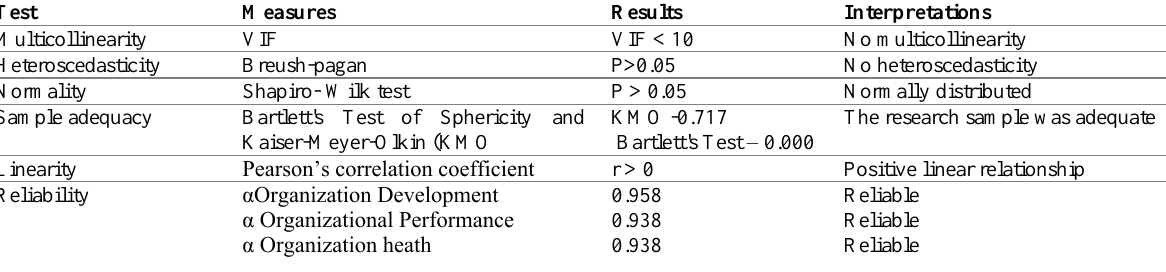
Table 1: Diagnostic test and reliability test